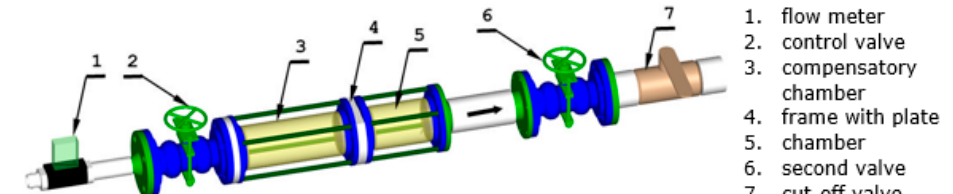
Figure 1. The test section view.